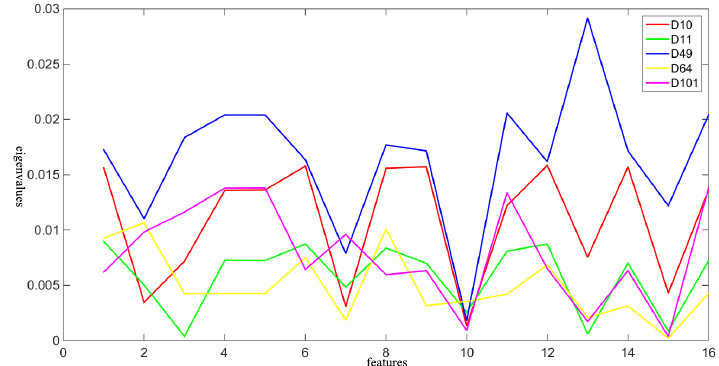
Figure 7. Difference of average eigenvalues between training and testing samples for Brodatz